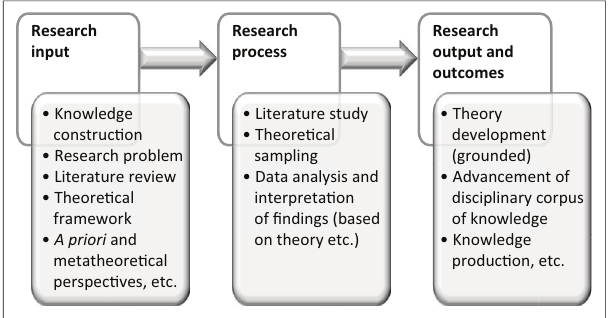
FIGURE 1: Locating theory in the research value